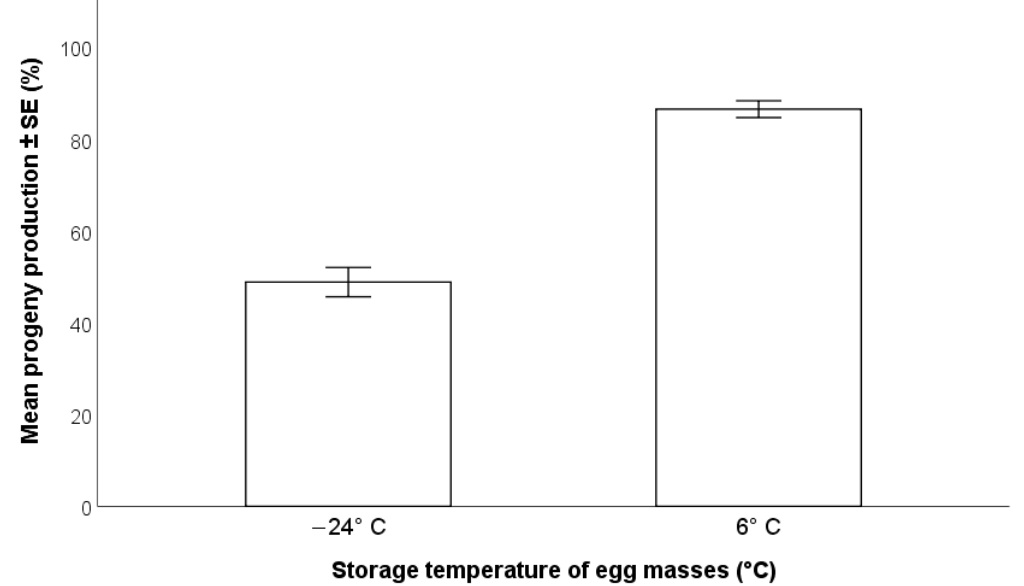
Figure 1. Effects of pre-parasitization storage temperature on the production of progeny by Trissolcus japonicus ( − 24 °C = 76 days; +6 °C = 60 days) (GLM, p < 0.001).